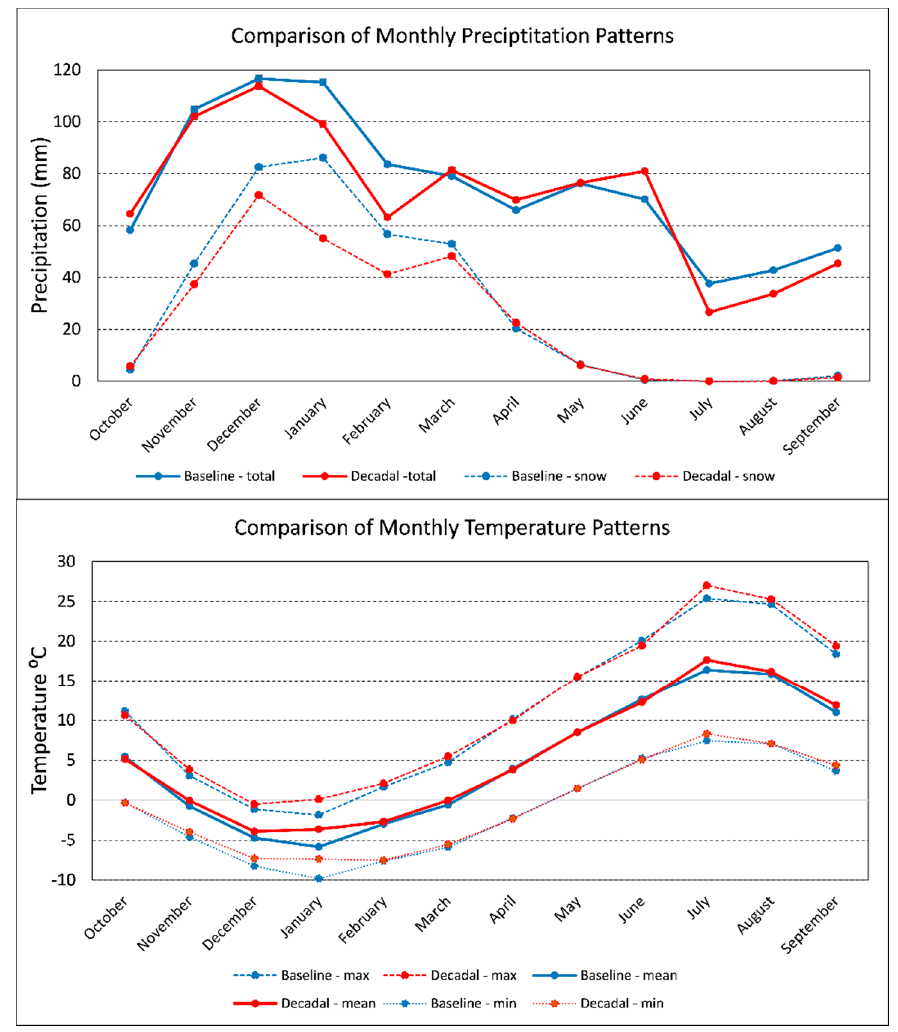
Figure A1. Graphs of seasonal precipitation and temperature patterns for baseline (1961–1990) and recent decadal (2001–2010) time periods for 1286 plot locations with western larch. Error bars show ±1 SE of mean; however, all standard error values are less than 1.5 mm for precipitation and 0.06 °C for temperature and thus error bars are not evident.